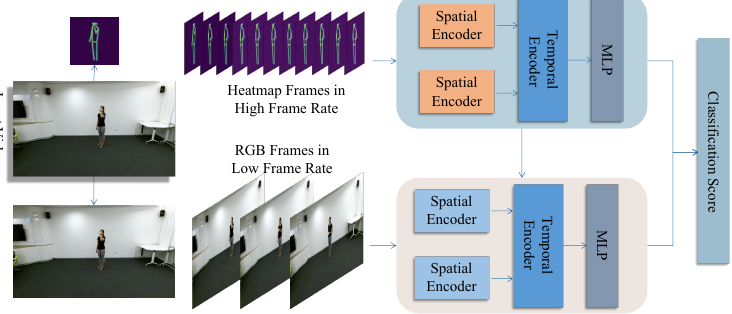
Figure 2. The overview of our proposed framework,